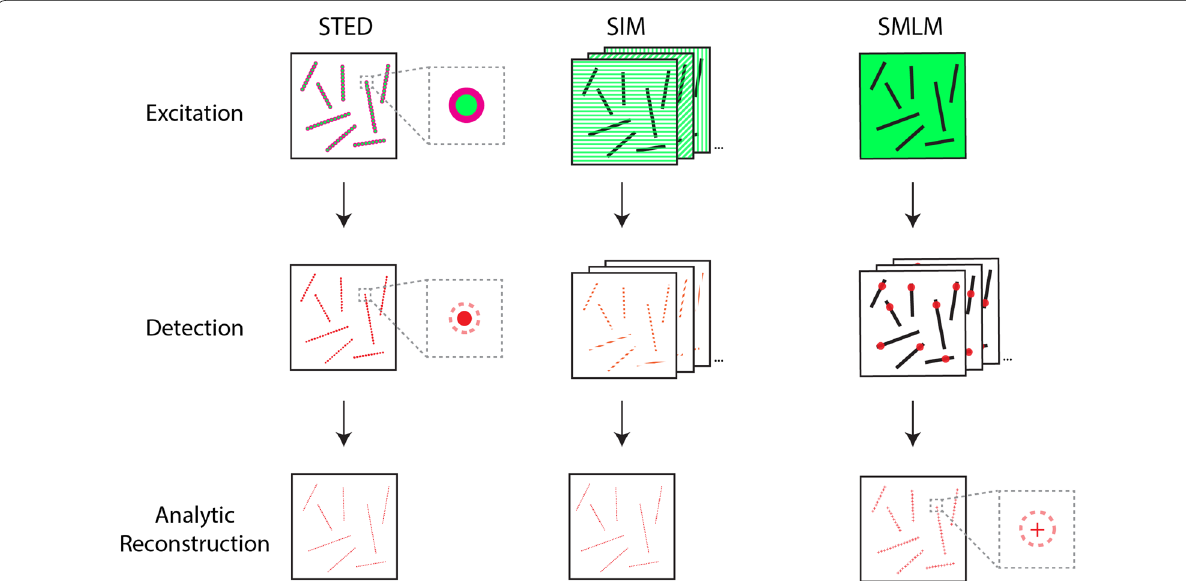
Fig. 1 Imaging principle of super-resolution microscopy techniques such as stimulated emission depletion microscopy (STED), structured illumination microscopy (SIM), and single-molecule localization microscopy (SMLM). STED: During excitation, two laser beams—a laser beam producing a fluorescent spot with a diffraction-limited size (green) and a second laser beam depleting a donut-shaped area around the excited spot (magenta)—generate a sub-diffraction-limit fluorescent point for detection (solid red). The excitation/depletion spot is then scanned across the sample to generate the final image. SIM: Patterned excitations are first performed with multiple shifts and rotations. The partial fluorescent images from these excitation patterns are then detected and combined using an algorithm to reconstruct the final image of the sample. SMLM: In one implementation, a subset of photoswitchable fluorophores will turn on and off each time the sample is excited. During this process, only a sparse subset of the fluorophores—those at the on-state—are detected. After repeating the excitation-detection cycle many times, an increasing number of the single fluorescence points are captured. The centers of these single fluorescence points are then computationally determined and combined to reconstruct the final image of the